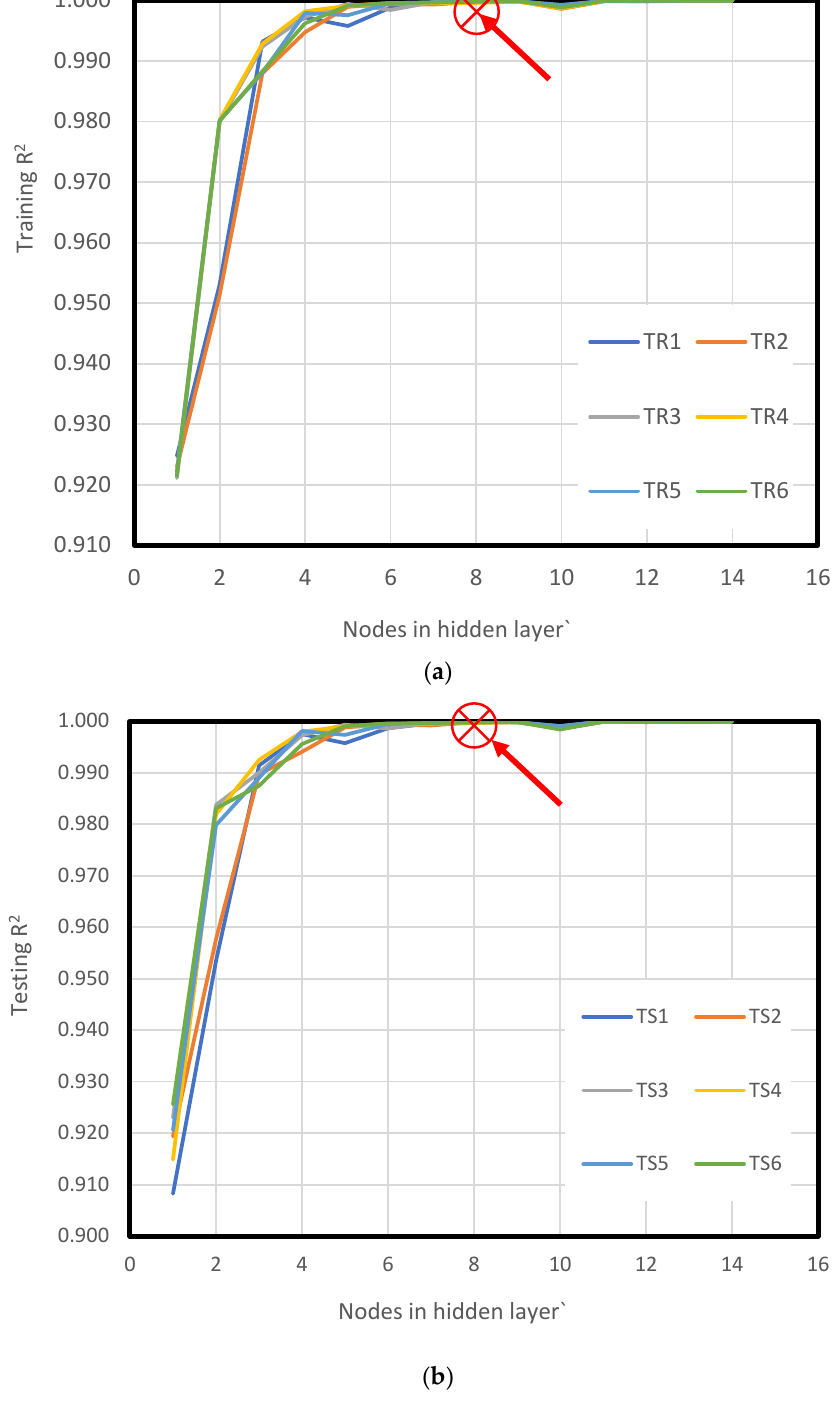
Figure 8. Variation of R 2 vs. the number of nodes in the estimation of F ult . ; ( a ) Training R 2 ; ( b ) Testing R 2 .